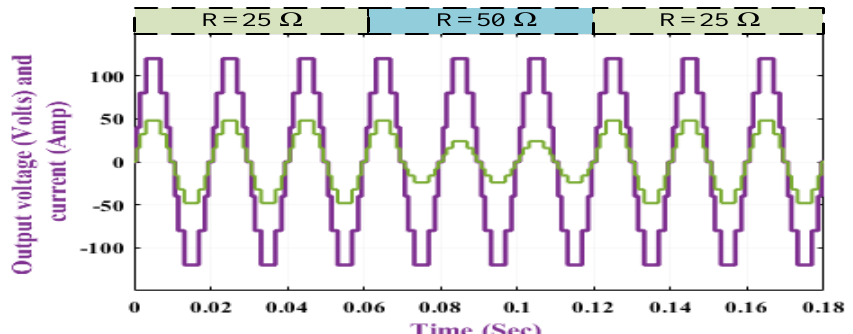
Figure 14. Dynamical R load in five-level changing from 25 Ω–50Ω– 25 Ω. The current waveform is multiplied by 10.